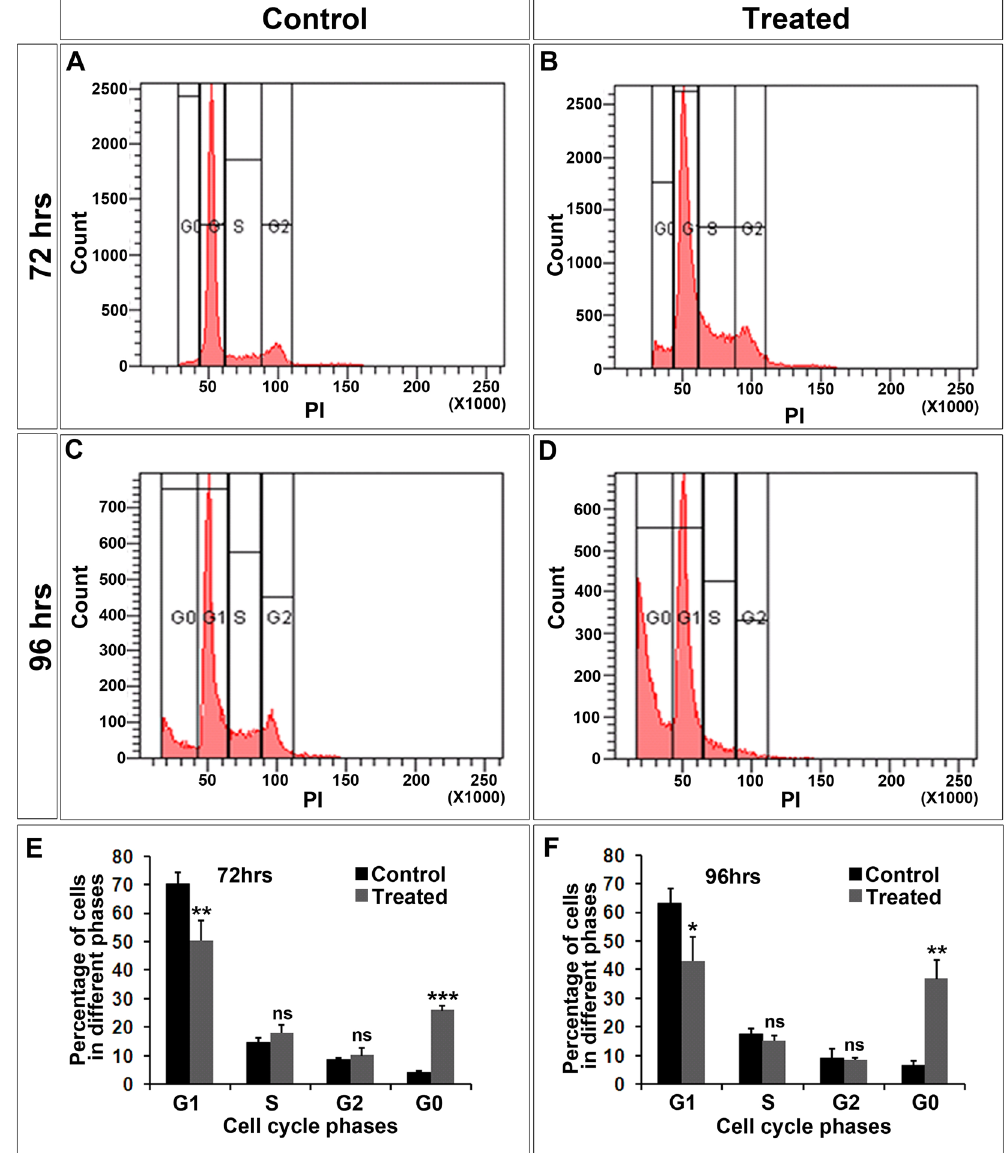
Figure 4. TALEN-treated cells undergo cell death as assessed by Propidium Iodide staining. FACS analysis of PI stained SiHa cells revealed that most of the TALEN-treated cells showed G1/S arrest. ( A ) Represents the FACS profile of control cells at 72 hours, ( B ) TALEN treated SiHa cells at 72 hours, ( C ) SiHa control at 96 hours, ( D ) TALEN treated SiHa cells at 96 hours. ( E , F ) Graphs depicting the percentage of cells in each stages of cell cycle during both time intervals of treatments. Data are expressed as mean ± SD from triplicates of three different experiments. ns = not significant, * P < 0.05, ** P < 0.001, *** P <